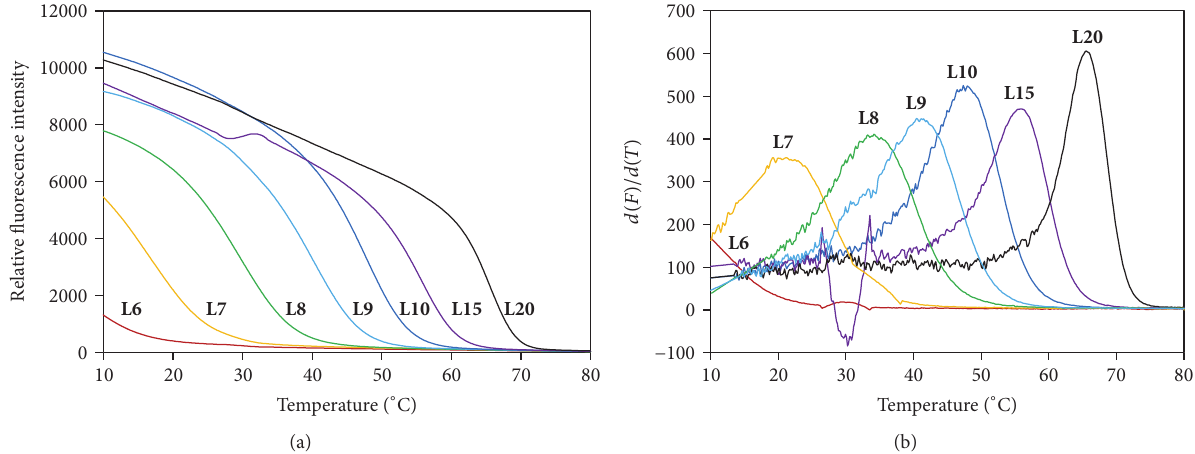
Figure 1: Fluorescence melting curves (a) and differential curves (b) of 6–20 bp DNA duplexes. Each DNA duplex (1 𝜇 M) was measured in a 10 𝜇 L solution containing 1x EvaGreen, 10mM phosphate (pH 7.4), and 100 mM NaCl.